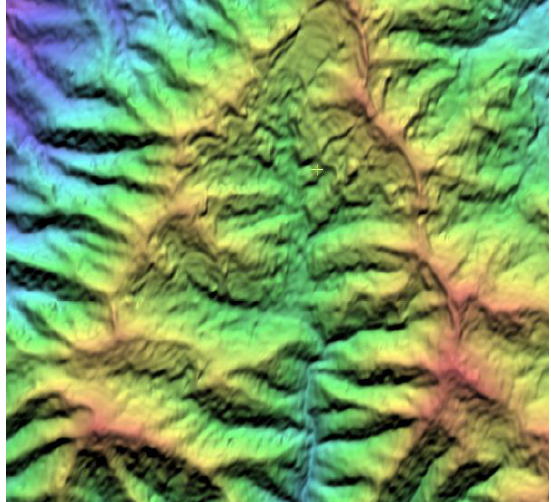
Figure 6. A sample from the forward-nadir